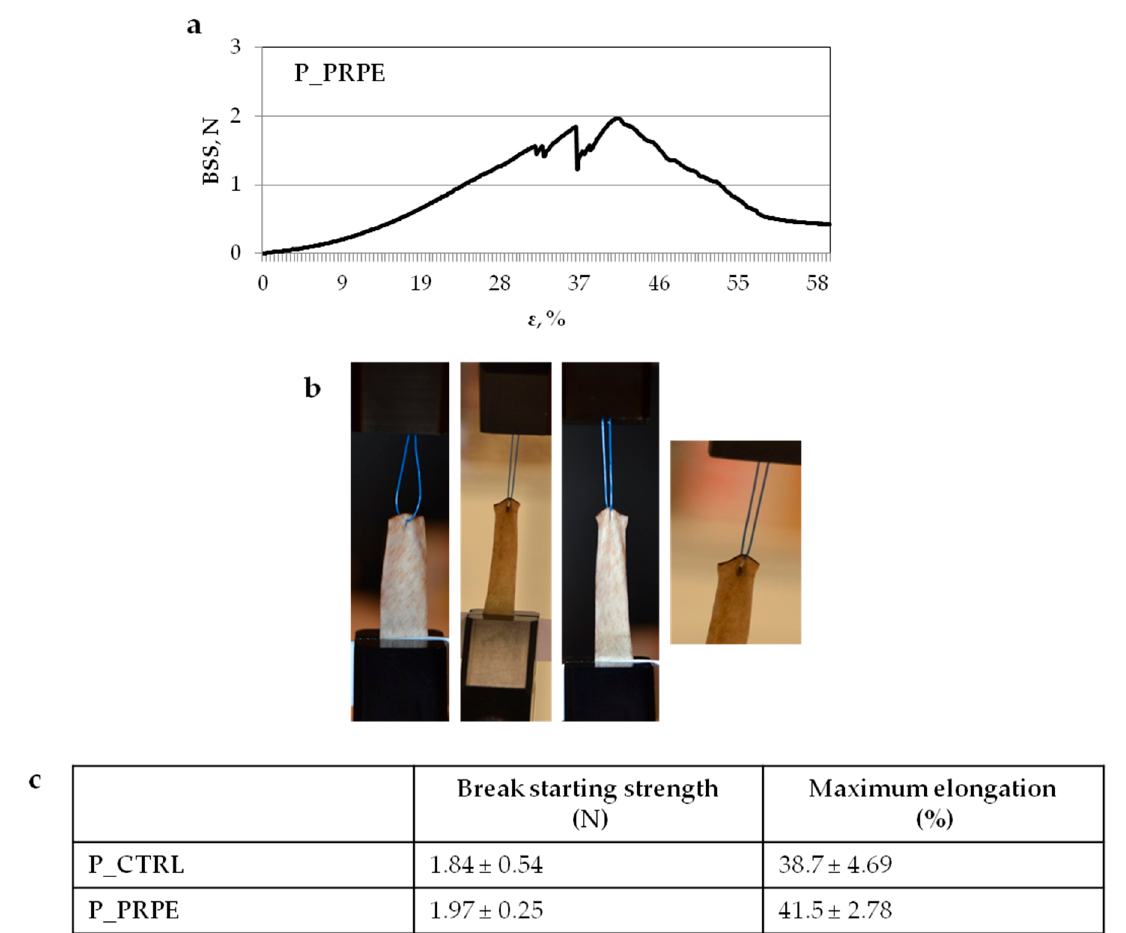
Figure 12. Suture retention strength test using Polypropylene monofilament USP 3/0 surgical suture. ( a ) stress–strain curve for P_PRPE sample. ( b ) Picture of the sequence during the suture retention test for P_PRPE membrane. ( c ) Mechanical parameters calculated from the stress–strain curve of the suture retention strength test.